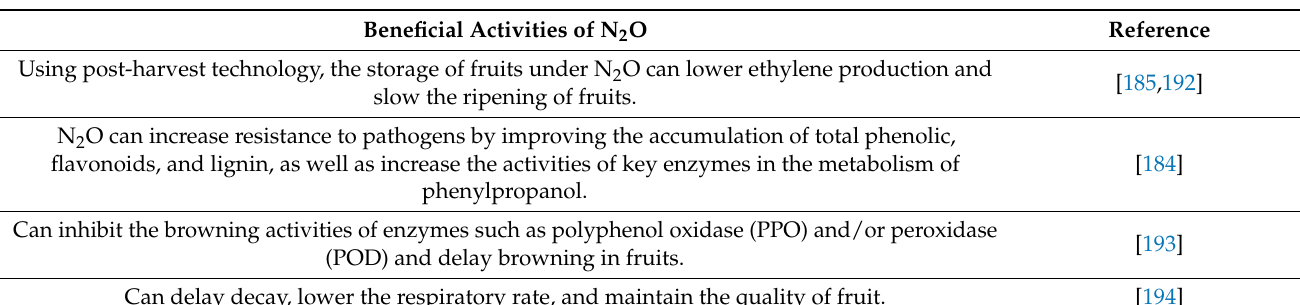
Table 3. Beneficial activities of N 2 O in plants. Beneficial Activities of N 2